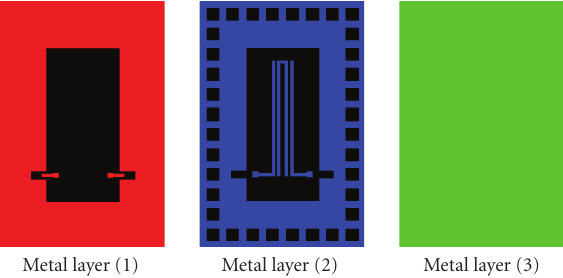
Figure 15: Configuration (2): metal